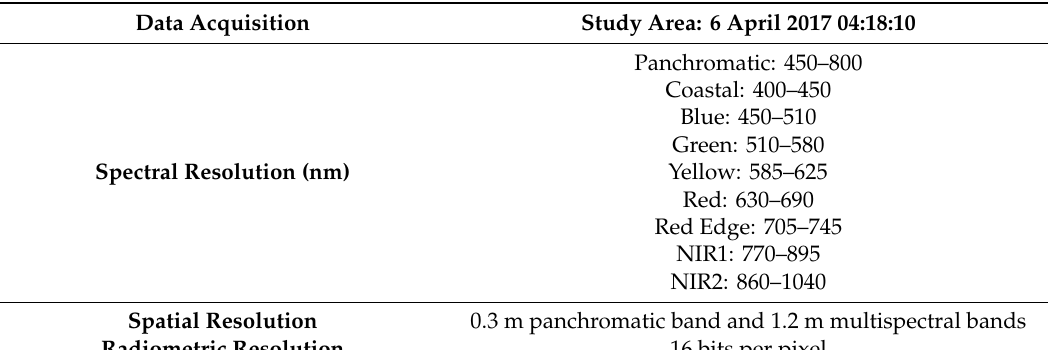
Table 1. Technical specifications of the WV-3 imagery.